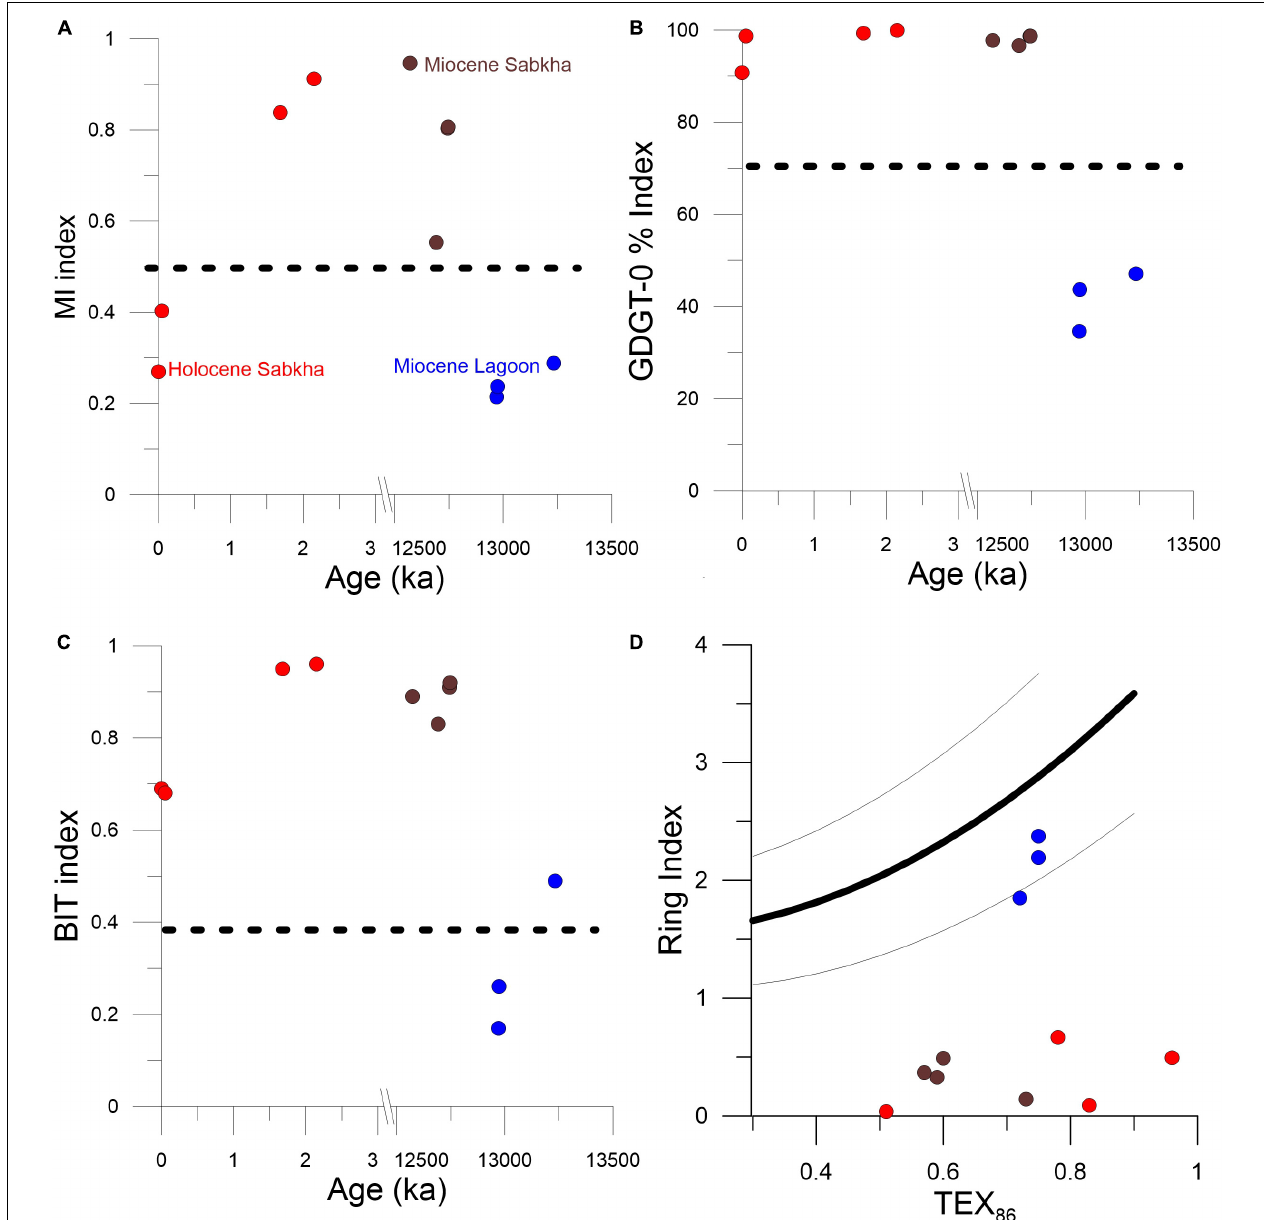
FIGURE 5 | GDGT Indexes in Sabkha and non-sabkha sediment samples. Miocene samples (brown) and Holocene (red) sabkha samples vs. Miocene non-sabkha samples (blue) (A) MI (Zhang Z. et al., 2011), (B) % GDGT-0 (Sinninghe Damsté et al., 2012), (C) BIT (Hopmans et al., 2004), and (D) Ring Index (Zhang et al., 2016).